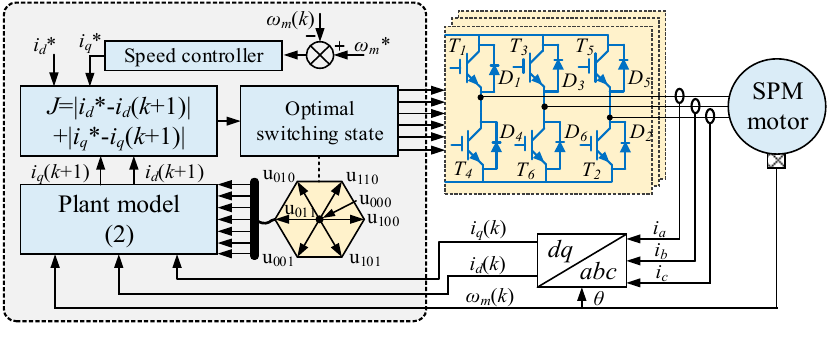
Figure 1. Block diagram of finite control set model predictive current control (FCS-MPCC) implementation.